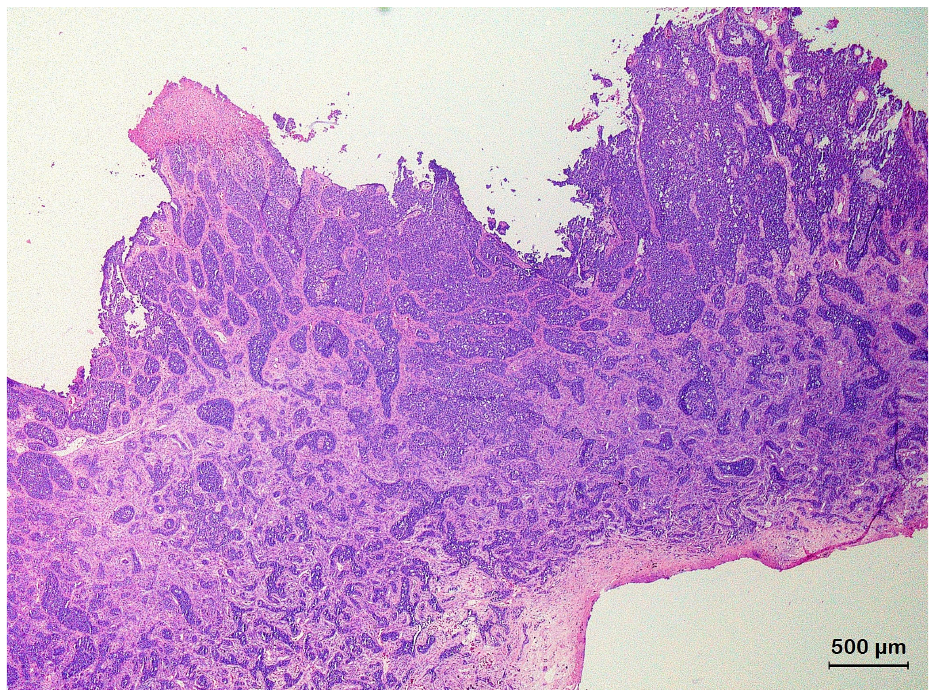
Figure 7. Histological section of an infiltrating basal cell carcinoma originating from the epidermis of the shell of a Hermann’s tortoise ( Testudo hermanni ) characterized by irregular, narrow, and elongated cords of small, atypical basophilic basal tumor cells.